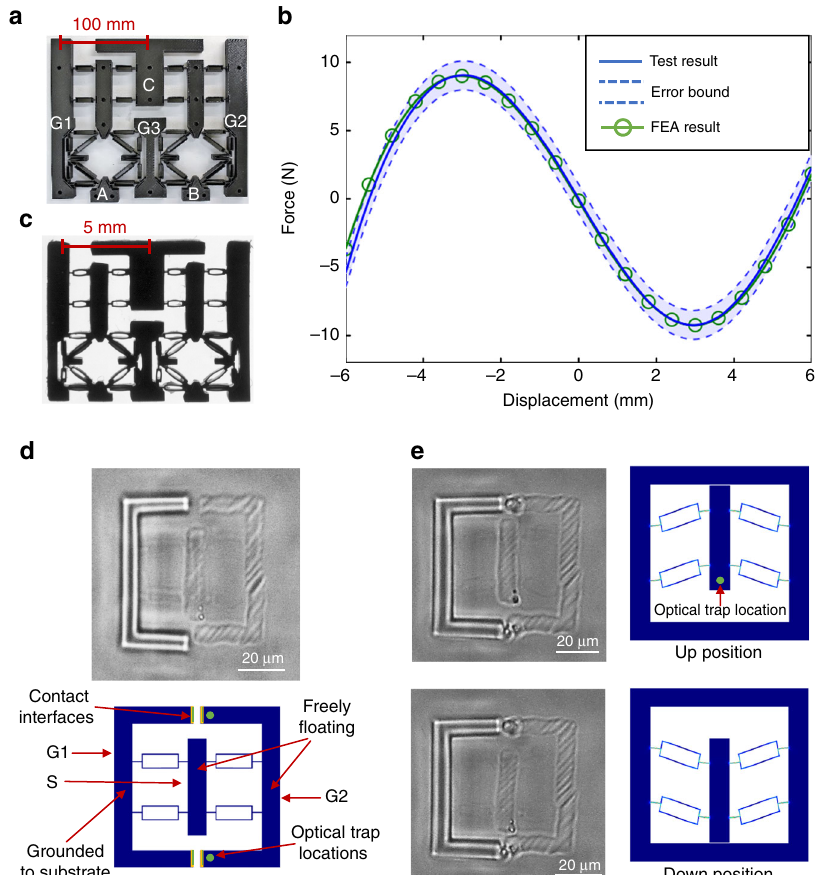
Fig. 3 Fabrication and experimental testing of the mechanical logic gates. a A macroscale NAND gate printed by a commercial Fused Deposition